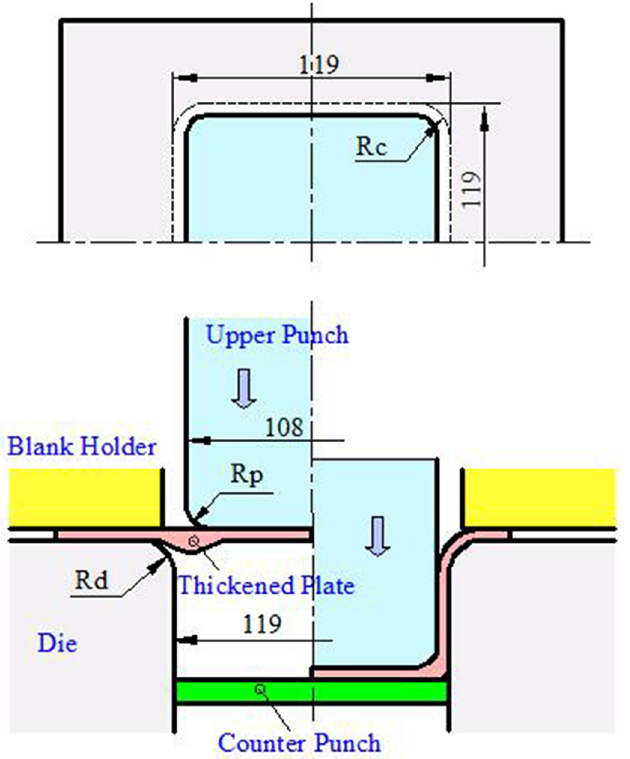
Fig. 4. Schematic representation of hot stamping of square cup with local-thickened plate.